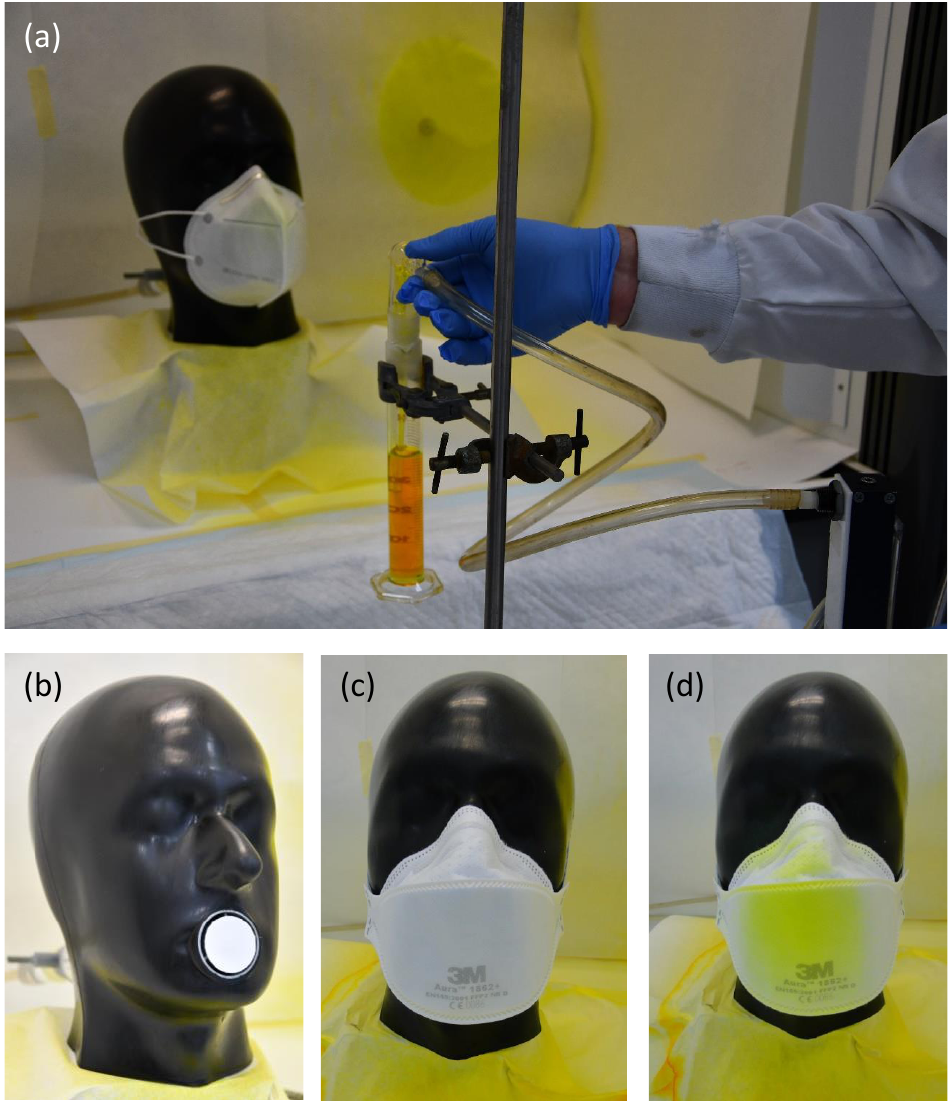
Figure 2. Test set-up for total inward leakage (TIL) test at 30 cm distance ( a ); Sheffield head with membrane filter placed in the mouth opening ( b ); 3M FFP2 Aura mounted on dummy head before ( c ) and after ( d ) spray sequence (with the yellow stain of fluorescein showing soiling of the respi- rator).